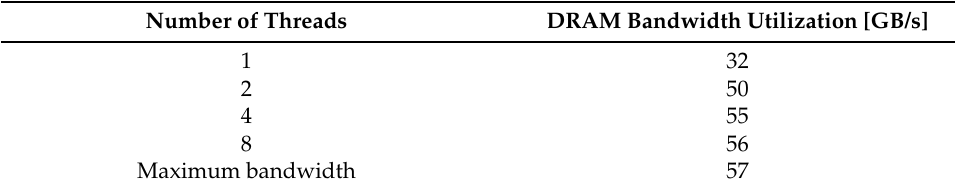
Table 5. Memory bandwidth utilization for computing the right-hand